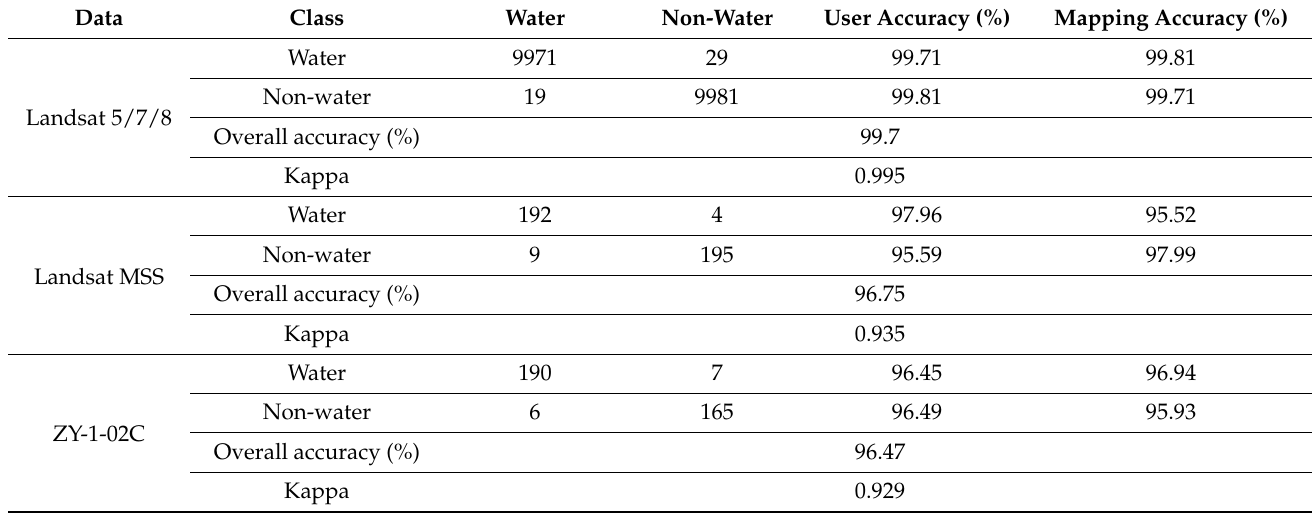
Table 4. Accuracy verification confusion matrix.